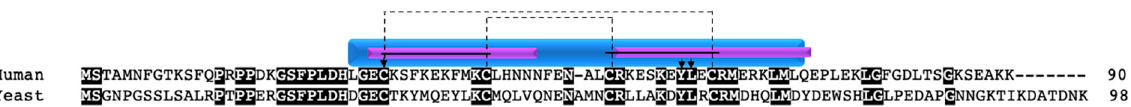
Figure 3. COX19. Alignment of human and yeast COX19 protein sequences. Black boxes indicate conserved residues. Blue box indicates the CHCH domain. Purple boxes indicate a helix. Solid black lines indicate the twin CX 9 C motif. Dashed lines indicate the cysteine pairs that form structural disulfide bonds. Arrows indicate copper binding cysteines.